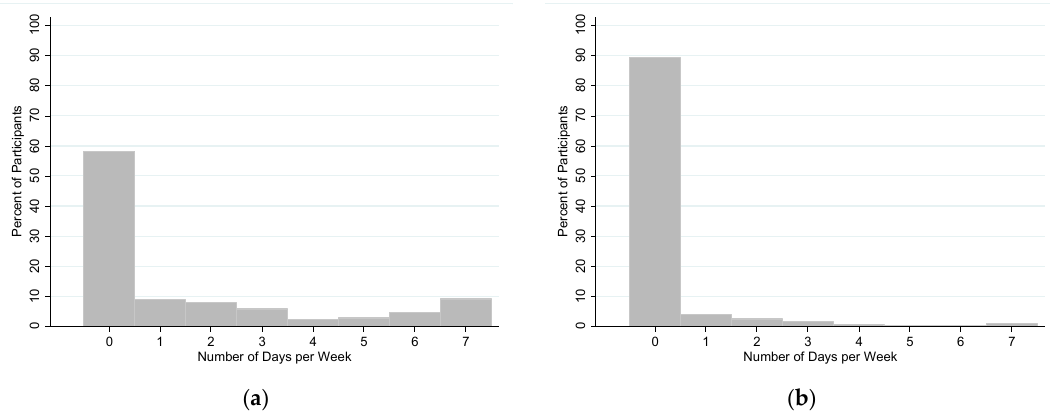
Figure 4. ( a ) Frequency of eating meals from a street vendor and ( b ) frequency of eating meals from a restaurant or cafeteria.